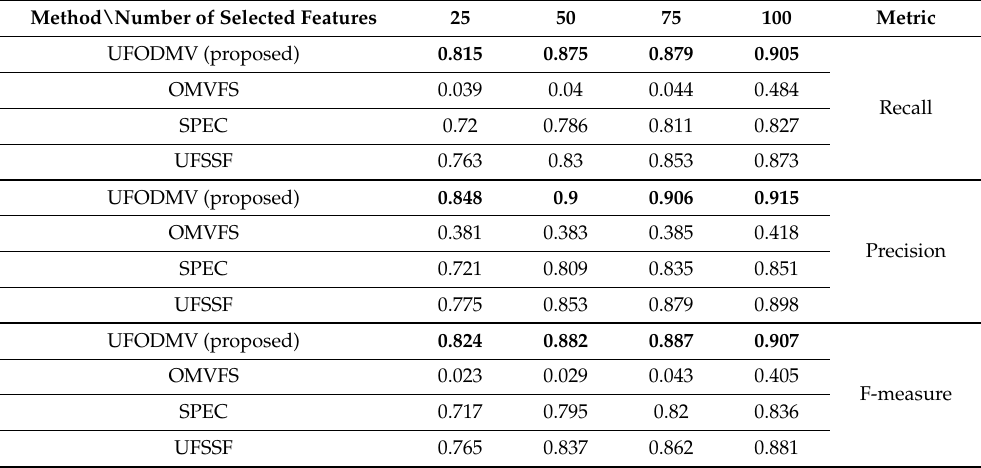
Table 5. Classification accuracy using Caltech dataset with naive Bayes.